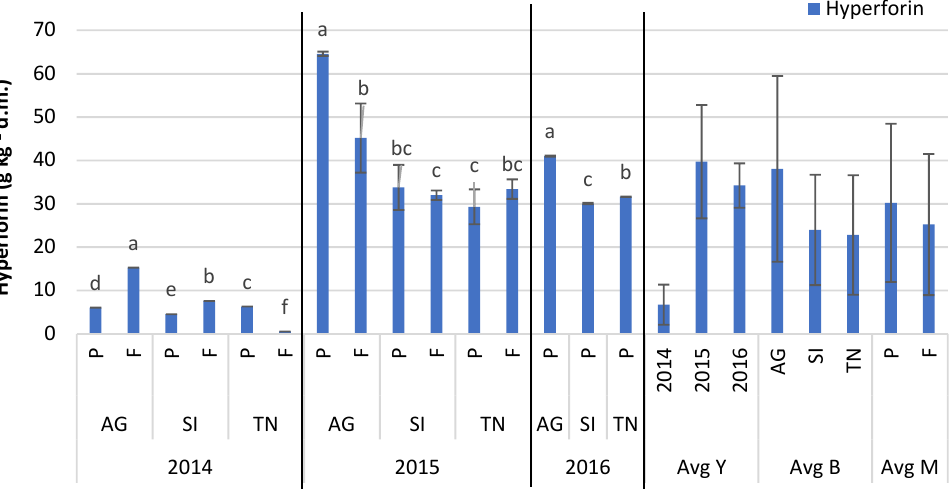
Figure 6. Mean values of hyperforin content (g kg − 1 d.m.) in flowering tops of 3 biotypes of H. perforatum (AG, SI, and TN), obtained in 2014, 2015, and 2016 from cultivations in pots (P) and in open field (F). Within each year, means that do not share a letter are significantly different at P ≤ 0.05 (Tukey’s test). Avg Y—yearly averages; Avg B—averages by biotype; Avg M—averages by cultivation management.